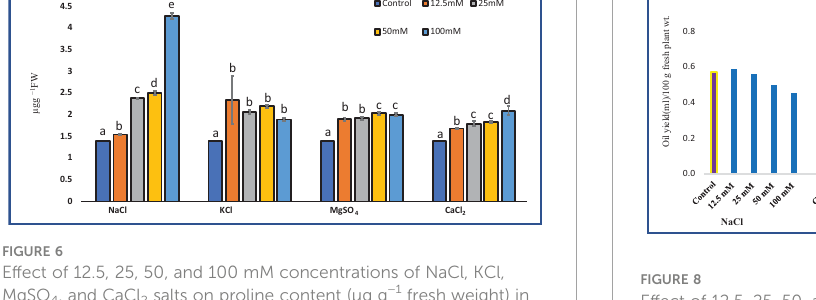
FIGURE 6 Effect of 12.5, 25, 50, and 100 mM concentrations of NaCl, KCl, MgSO 4 , and CaCl 2 salts on proline content (µg g − 1 fresh weight) in an M. longifolia leaf sample. The data are represented as mean ± standard deviation (n = 3). The different letters on the same color bar show the signi fi cantly different groups according to the Duncan test ( a = 0.05).